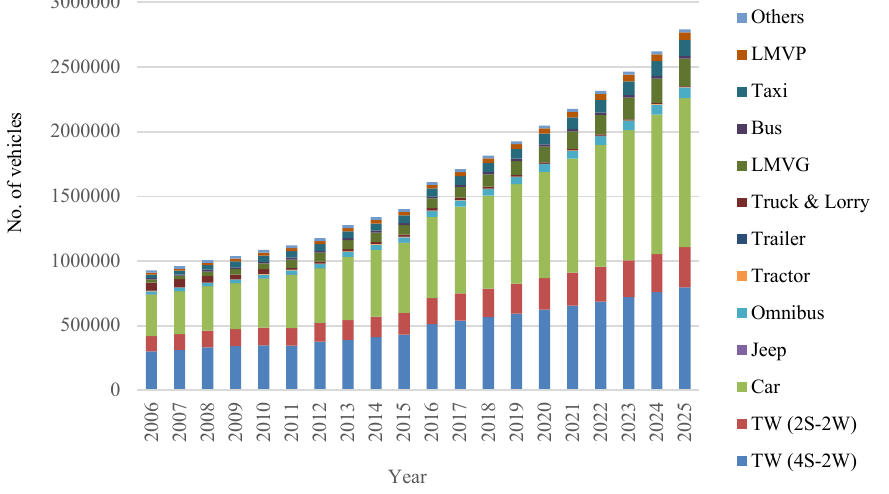
Fig. 2. Vehicle population in Kolkata